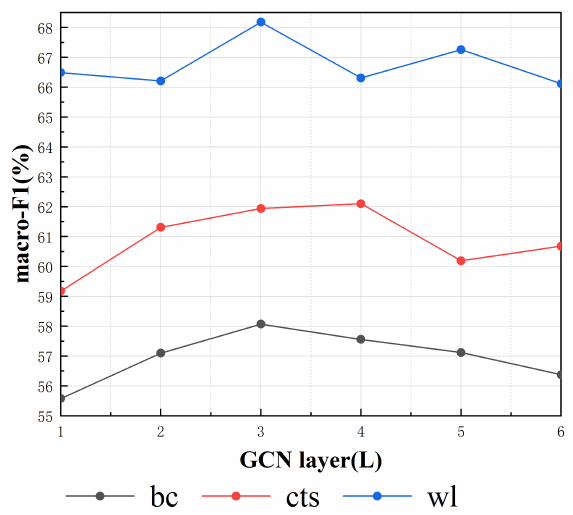
Figure 8. Macro-F1 values with different numbers of GCN